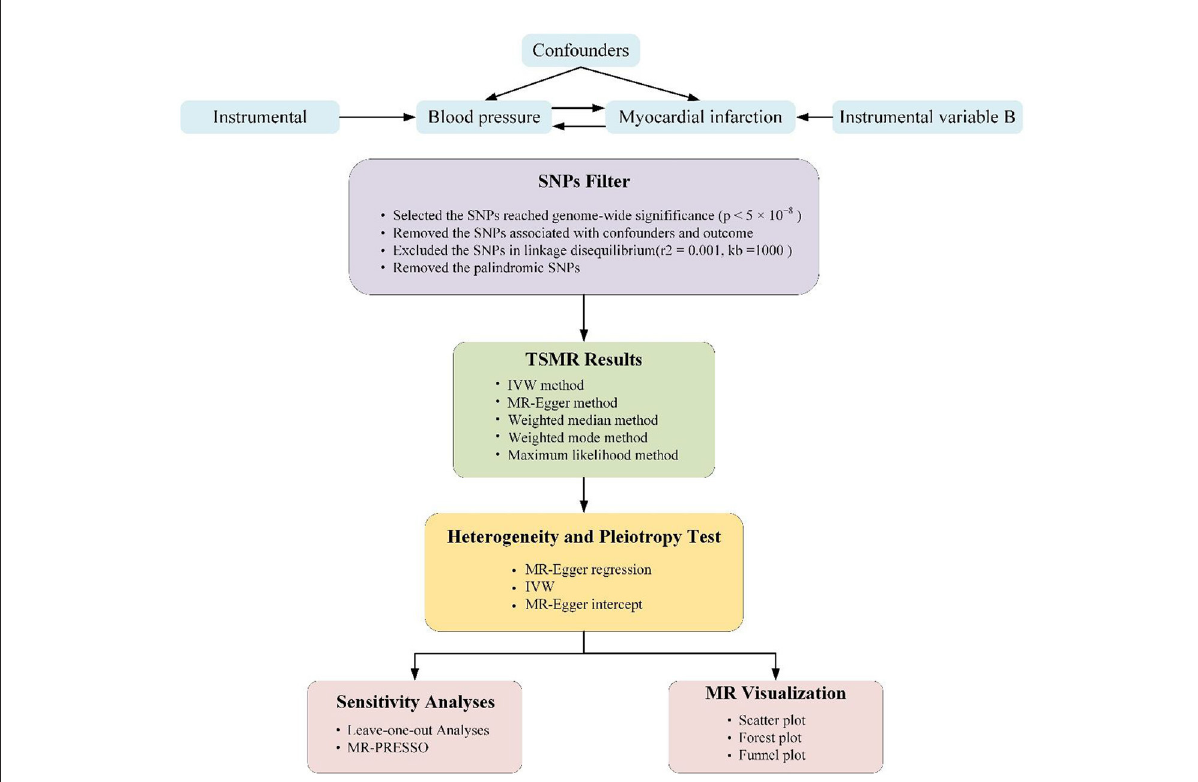
FIGURE1 Schematic representation of two-sample Mendelian randomization (TSMR) analysis of our study. The three core assumptions of Mendelian randomization (MR) analysis are as follows: (1) instrumental variables (IVs) must be associated with blood pressure (BP) or myocardial infarction, (2) IVs must not be associated with confounders, and (3) IVs must influence outcome only through